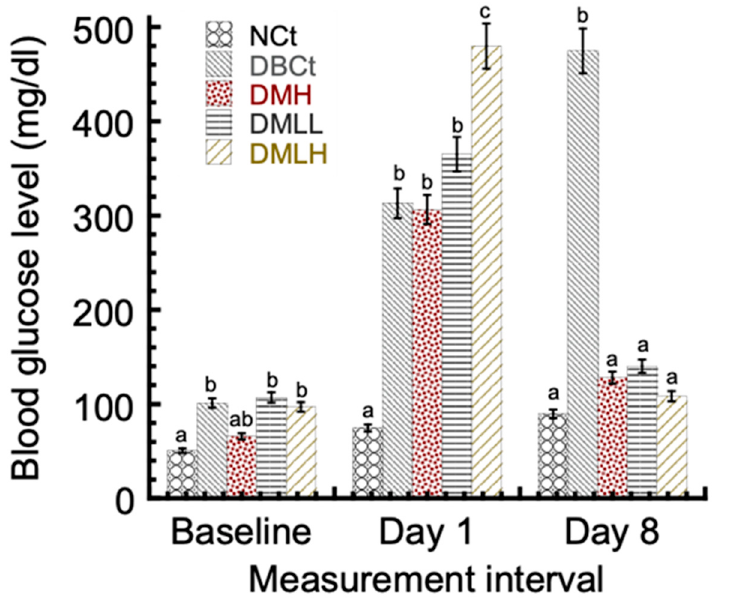
Figure 4. Effect of metformin hydrochloride-loaded lipid vesicles on the blood glucose level of rats. *NCt: Normal control; DBCt: Diabetic control; DMH: Diabetic + 5 mg/kg body weight free MH; DMLL: Diabetic + low dose (2.5 mg/kg body weight MH-LLV); DMLH: Diabetic + high dose